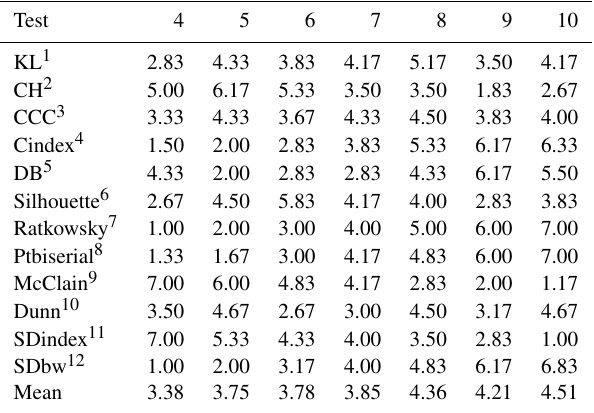
Table 2. Mean ranking of proposed cluster groups across OND and JFM during three super El Niños for tests used in the R package NbClust (version 3.0). Low scores denote the highest ranking. CCC: cubic clustering criterion; Cindex: clustering index; SDindex: scat- tered distance index; SDbw: scattered